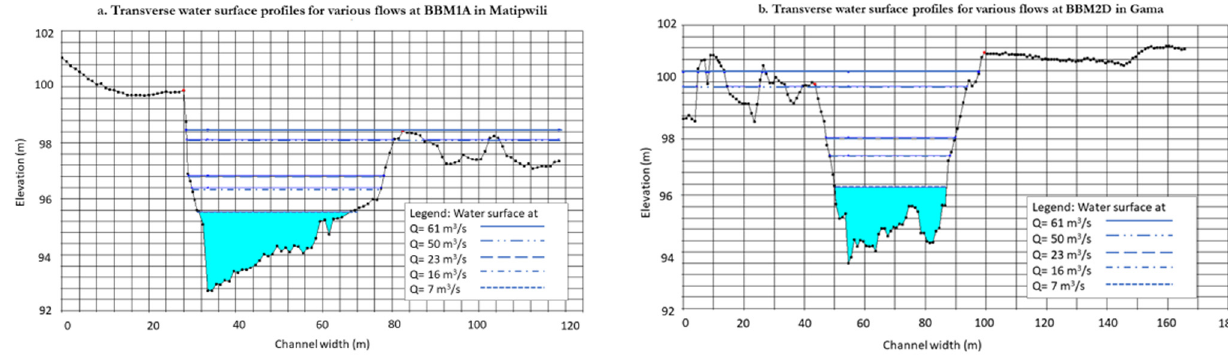
Figure 5. Channel cross-sections and simulated water surface profiles for different flowrates at ( a ) Matipwili and ( b ) Gama Gate, Wami River, Tanzania.